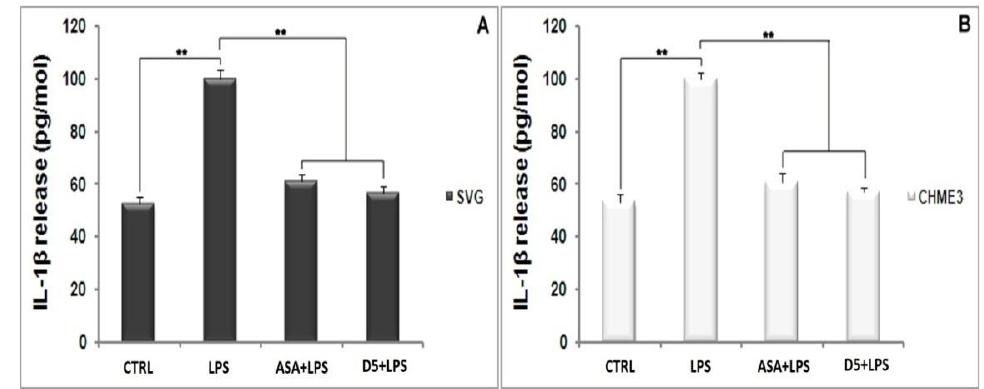
Figure 4. Inhibitory Effects of D5 on IL-1 β production in LPS-Stimulated astrocyte (SVG) and microglia (CHME3) cell lines. Astrocytic glial (SVG) and microglial (CHME3) cells were treated with D5 and ASA (0.71 µ M and 52.73 µ M, respectively) for 2 h, and then incubated with LPS (100 ng/mL) for 24 h. Amounts of IL-1 β released from SVG ( A ) and CHME3 ( B ) cells into the culture medium were measured using a human IL-1 β ELISA kit based on the quantitative sandwich enzyme immunosorbent technique. Quantitative analyses were shown as % or fold increases inthe control unstimulated group. Data are presented as the mean ± SD of four samples in one independent experiment. The data were replicated in three repeated independent experiments. ** p < 0.01 probability.